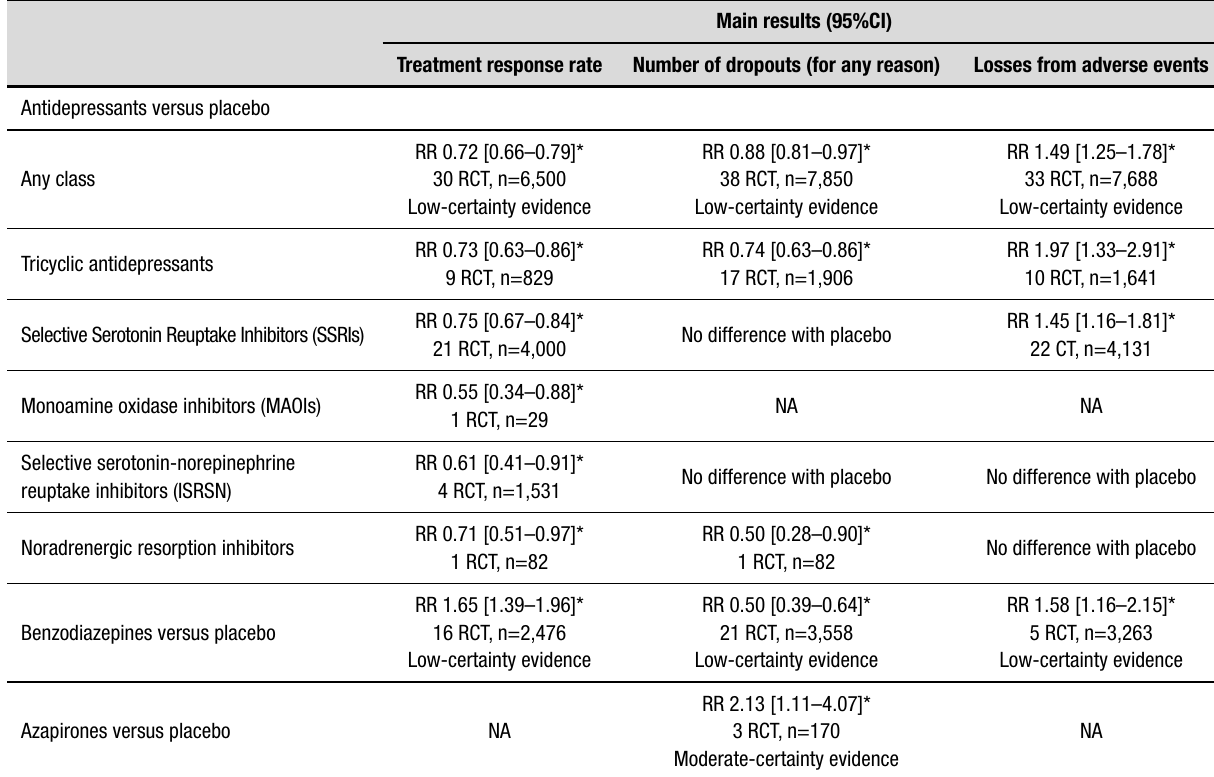
Table 3. Evaluation of the methodological quality of the included systematic